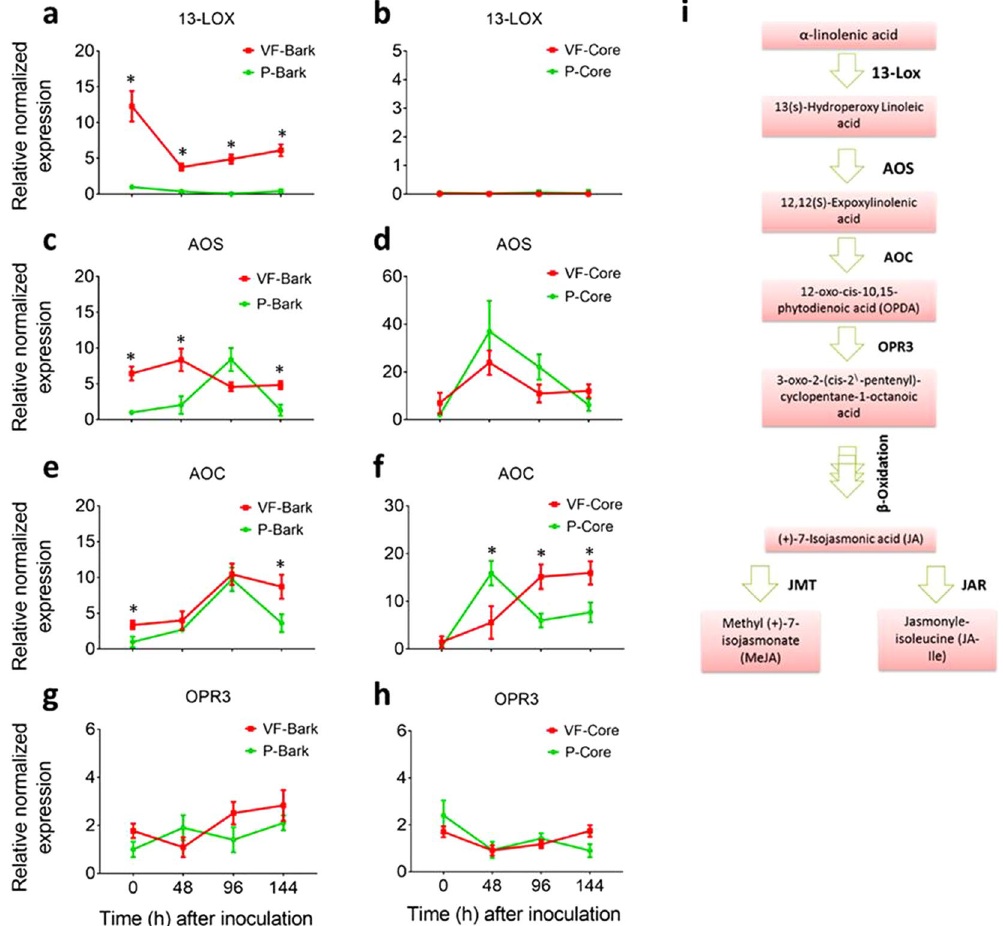
Figure 6. Expression of JA-biosynthesis genes in infected and non-infected tissues of ‘Valley Forge’ and ‘Princeton’. ( a–h ) The relative normalized expression of genes encode linoleate 13S-lipoxygenase (13S-LOX), allene oxide synthase (AOS), allene oxide cyclase (AOC) and OPDA-reductase 3 (OPR3), respectively, in the mock-inoculated (0 hpi) and inoculated bark ( a , c , e , g ) and core ( b , d , f , h ) tissues of Valley Forge’ (VF) and ‘Princeton’ (P). The expression of each gene was normalized to that of three elm reference genes ( EIF 5a , vacuolar ATP synthase and splicing factor 3B ) and was calculated relative to the control sample (P-bark at 0 hpi). The results are the mean ± SE of three biological replicates. Values marked with an asterisk ( * ) are significantly greater ( ≥ 2 times) than the control sample and the corresponding time point in the other genotype (P < 0.05). ( i ) A schematic overview of the major steps and enzymes in the JA biosynthesis